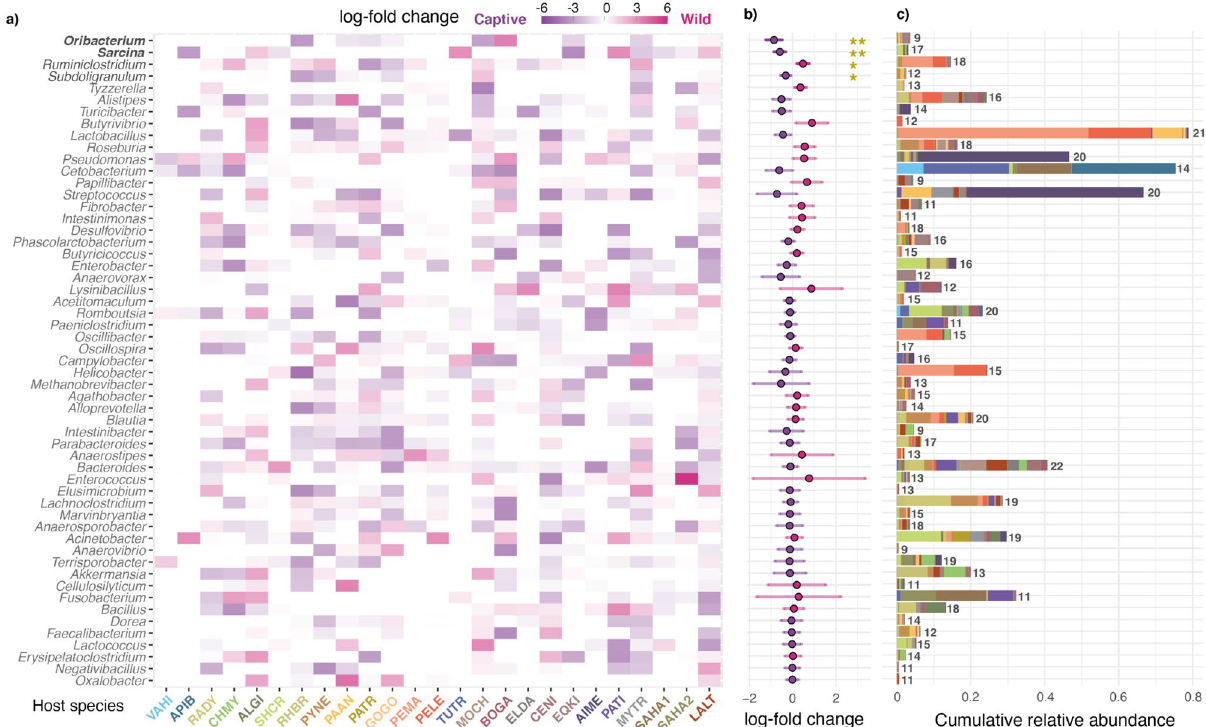
Figure 3. Differential abundance of the microbial taxa with highest prevalence. The listed microbial taxa were detected in more than a 33% (9) of the studies. ( a ) Log-fold changes of the most prevalent taxa in each host species. Purple tones indicate enrichment towards captive conditions, while pink tones indicate enrichment towards wild conditions. ( b ) Log-fold change estimates and their standard errors derived from the random effects meta-analysis of microbial abundances. Two stars indicate p-values under 0.05, while a single star indicate p-values under 0.1. ( c ) Cumulative relative abundances of taxa across the analysed datasets. Each coloured box indicates the mean relative abundance value of the microbial taxa in each study. Numbers indicate number of host species in which each taxon was detected. Abbreviations are explained in Fig.